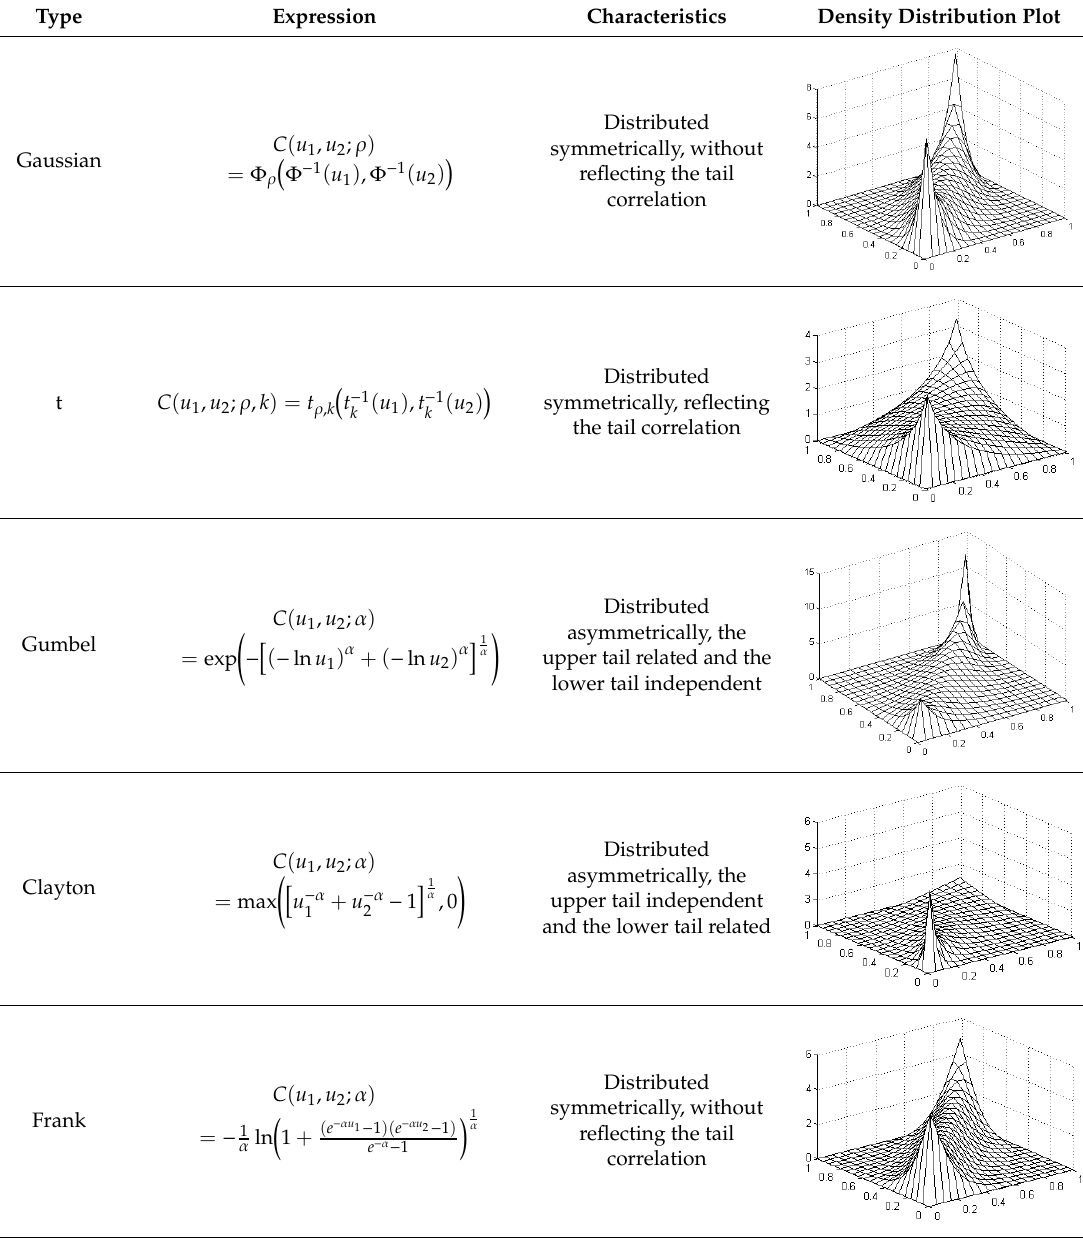
Table 1. The general information of five commonly used Copula functions.